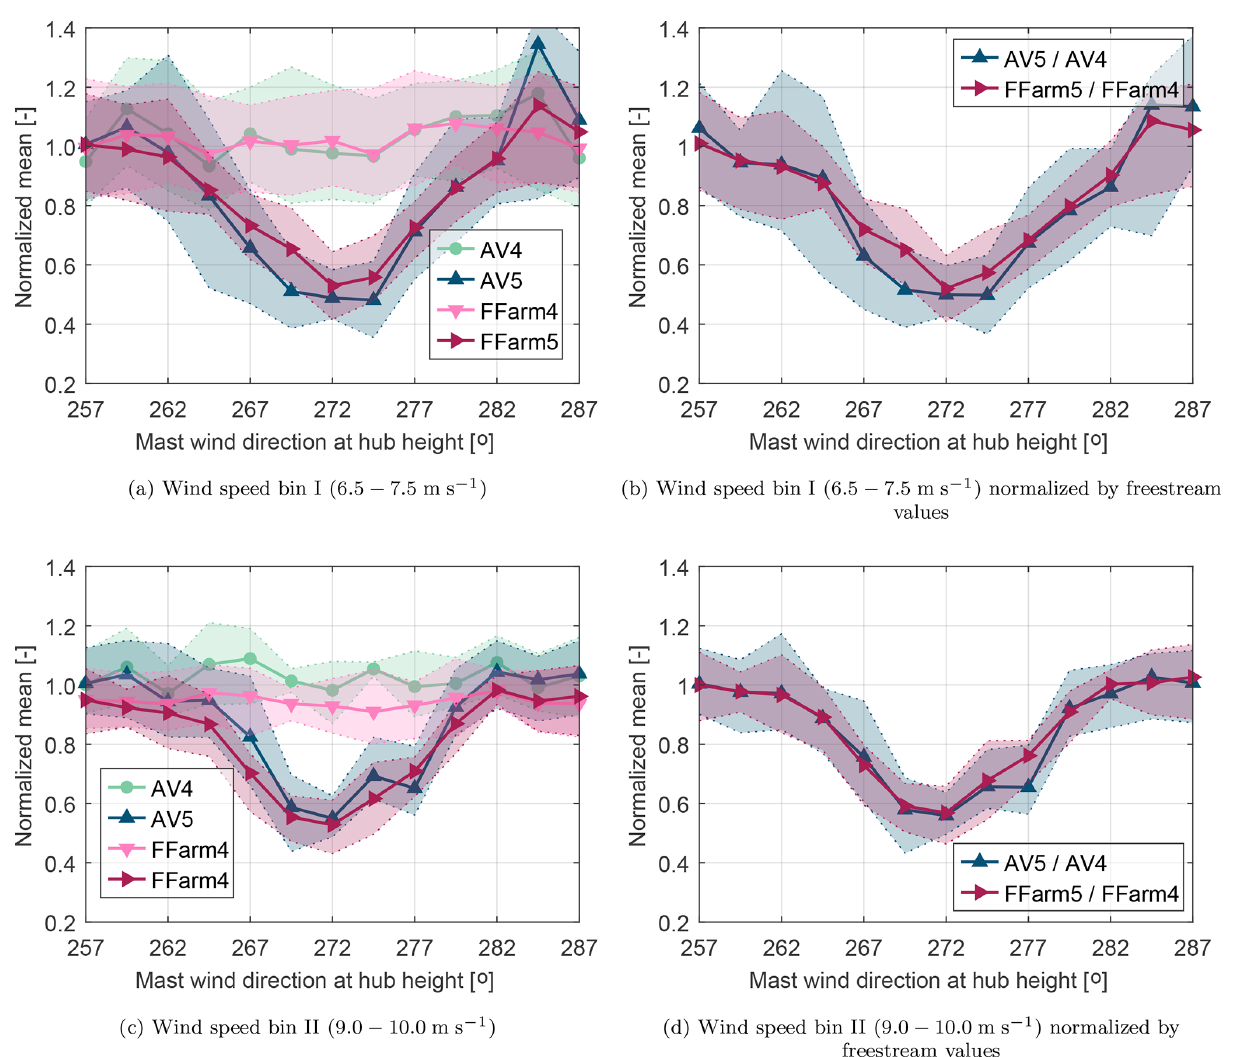
Figure 6. Comparison of generator power in wake conditions between measurements (AV4, AV5) and simulations (FFarm4, FFarm5). Statistics are shown as mean values per wind direction bin. The shaded area indicates the 15th and 85th